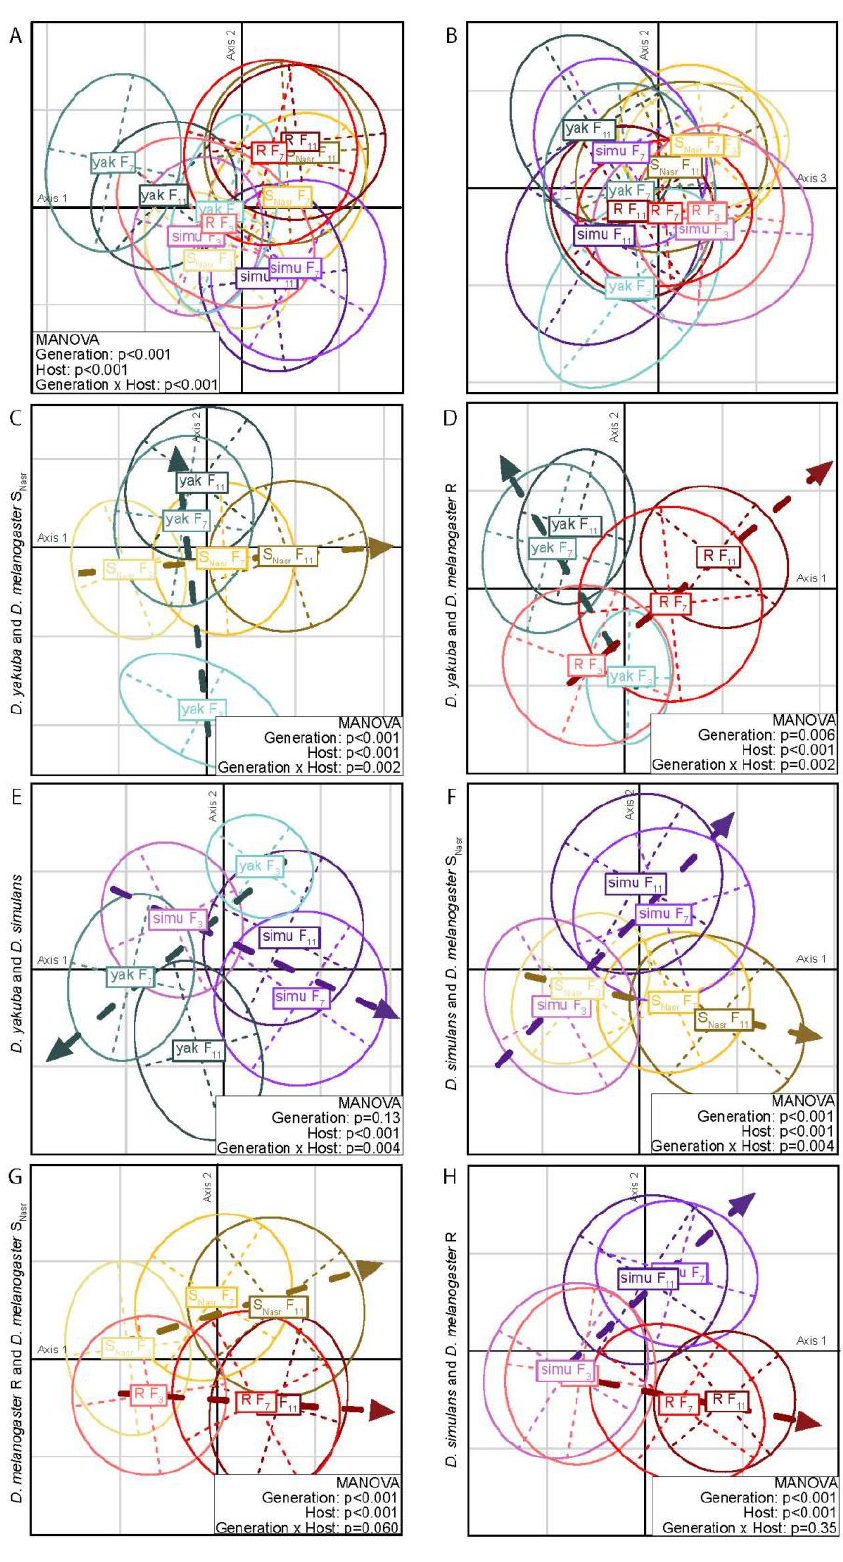
Figure 4. Differential evolution of venom composition. Discriminant analysis showing ellipses and centroids (intersection of dashed lines) of each group formed by the host and the generation are represented (see Figure S4 for more details on the position of each individual). The name of each group is written on the centroid. S Nasr : D. melanogaster S Nasr ; simu: D. simulans ; R: D. melanogaster R; yak: D. yakuba 307. A-B. Venom evolution in response to the four hosts at F 3 , F 7 and F 11 generations on